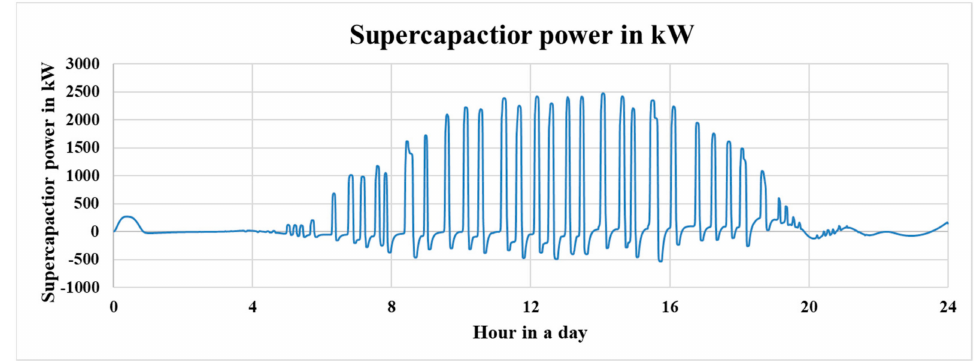
Figure 7. PV generation and load profile in selected day.